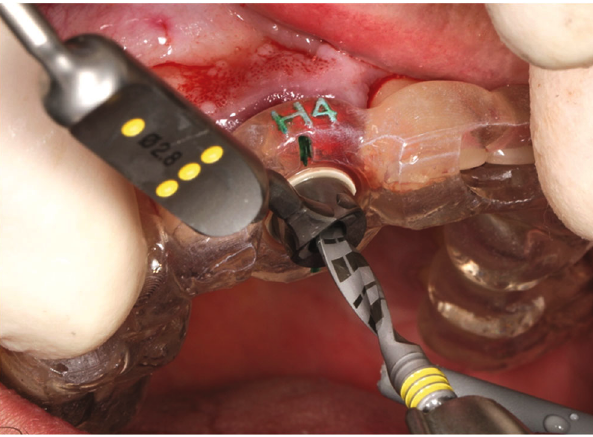
Figure 7: The surgical stent – drill guide fi xed in place.